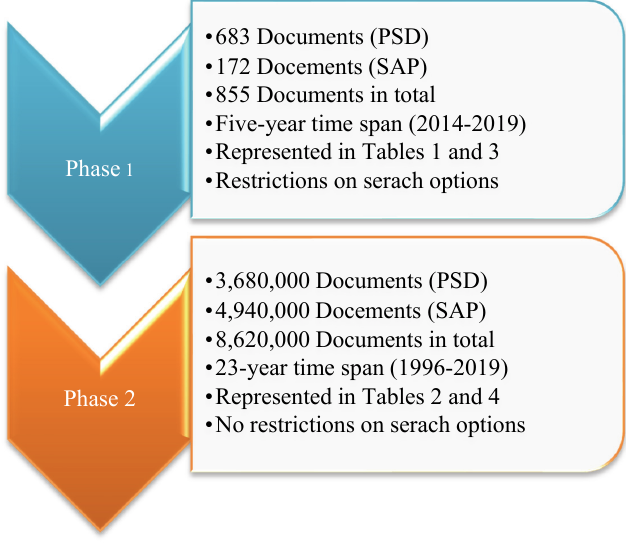
Fig. 2. A summary of the systematic literature review